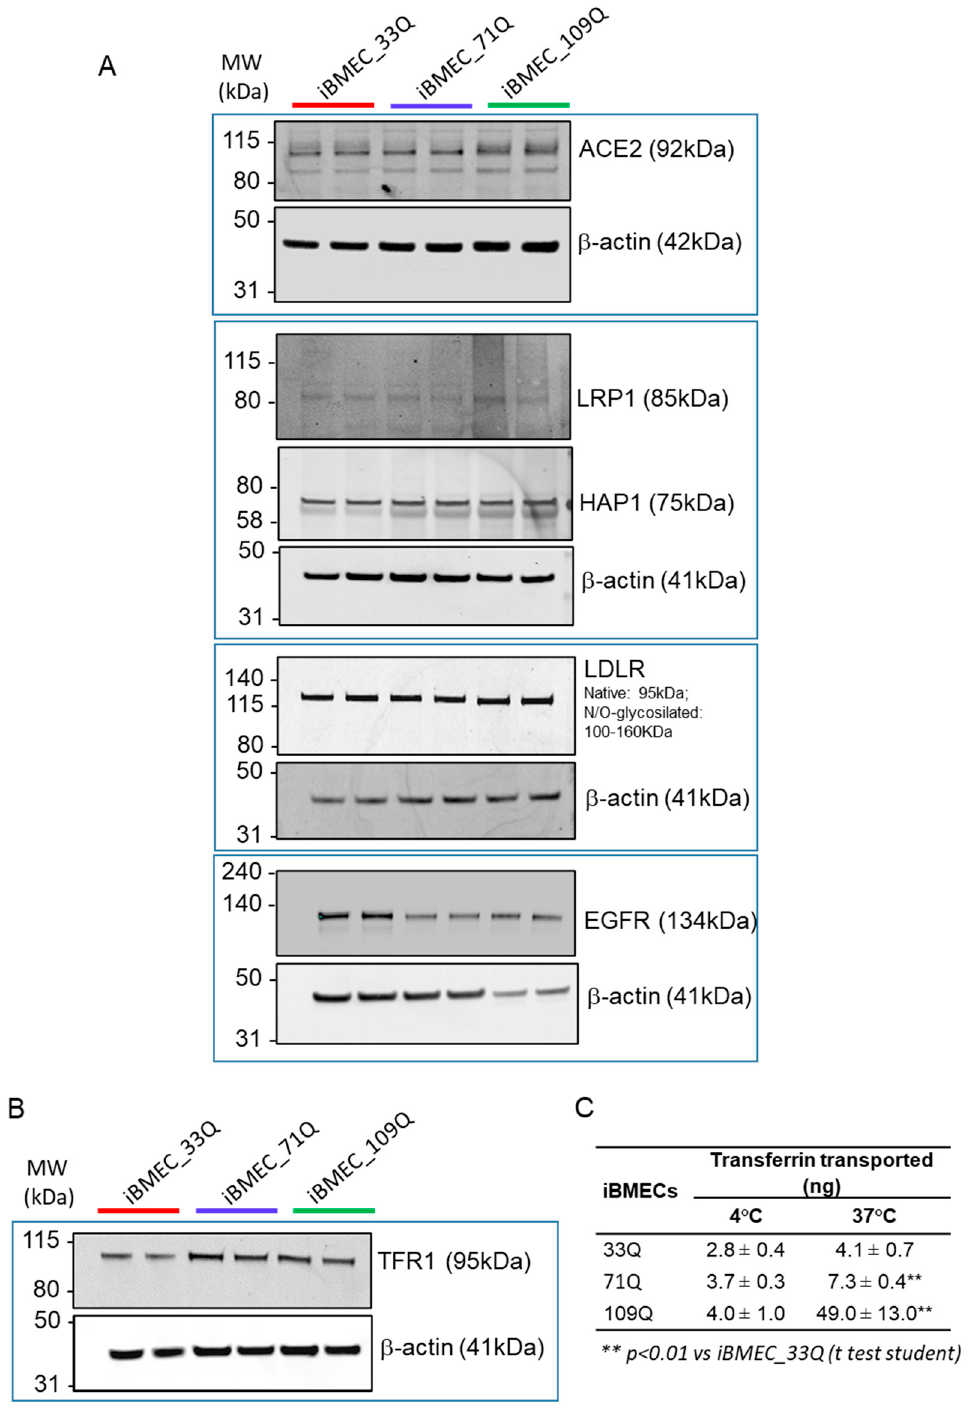
Figure 7. Expression levels of major BBB receptors and receptor-mediated transcytosis of Transferrin in the iBMECs. ( A ) Representatively cropped Western blot confirming the expression of ACE2, LRP1, HAP1, LDLR, and EGFR in iBMECs. β -actin was used as the loading control. ( B ) Representative cropped Western blot confirming the expression of TFR1 in iBMECs. Β -actin was used as the loading control. ( C ) iBMECs support the transcytosis of the transferrin; measured at 37 and 4 °C in the basal compartment after 2 h is the mean ± sd.